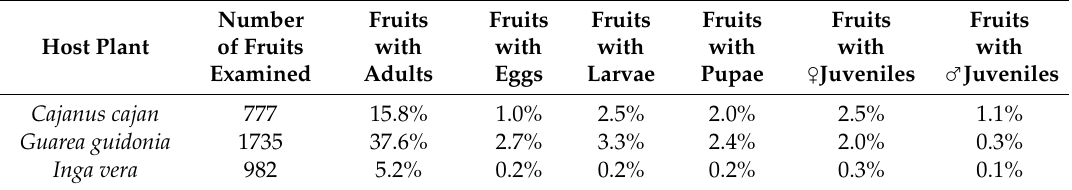
Figure 1. Number of Scolytinae beetles and Hypothenemus hampei found in potential alternate hosts per month. Fruits are not present from January to May; the dry season is February and March. Table 4. Frequency of life cycle stages of scolytid beetles. Reproduction was only observed in three of the eight plant species examined. Adults were most common stage in all three species.